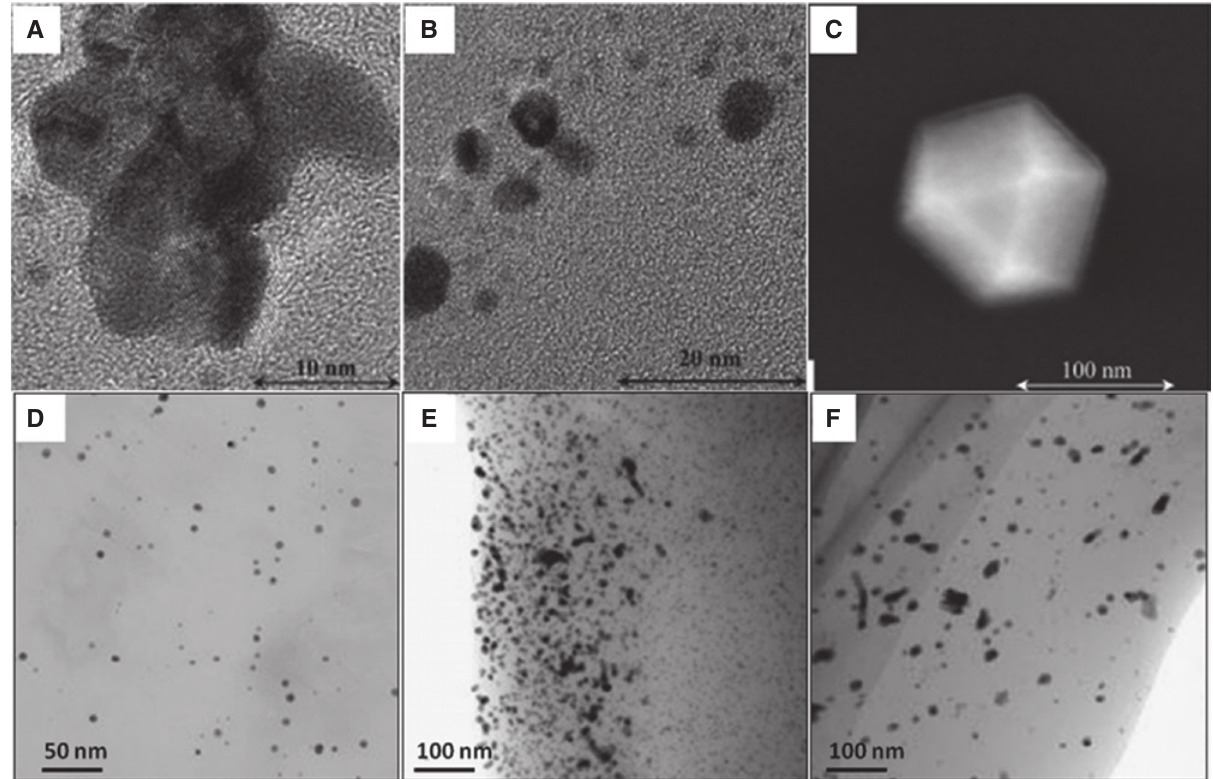
Figure 8: Nanocomposites where the metal NPs morphology is influenced by different experimental conditions: Pt NPs incorporated in β -cyclodextrine with diameters of (A) < 20 nm, (B) < 100, and (C) > 100 nm depending on the procedure. Reprinted with permission from Pelka J, Gehrke H, Esselen M, Türk M, Crone M, Bräse S, Müller T, Blank H, Send W, Zibat V, Brenner P, Schneider R, Gerthsen D, Marko